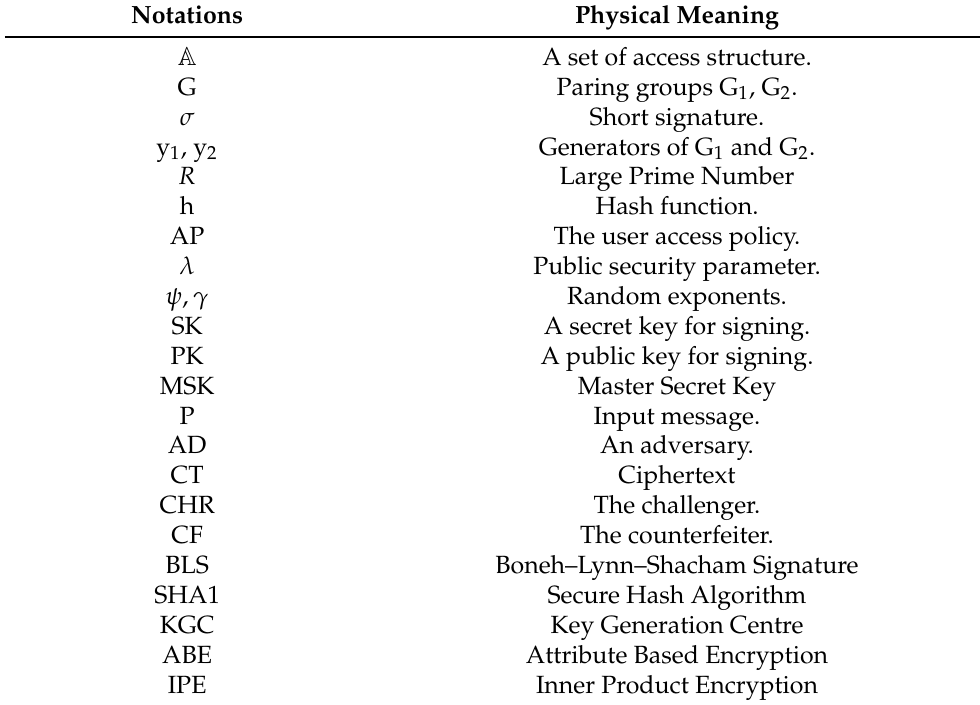
Table 2. Notations used for the proposed